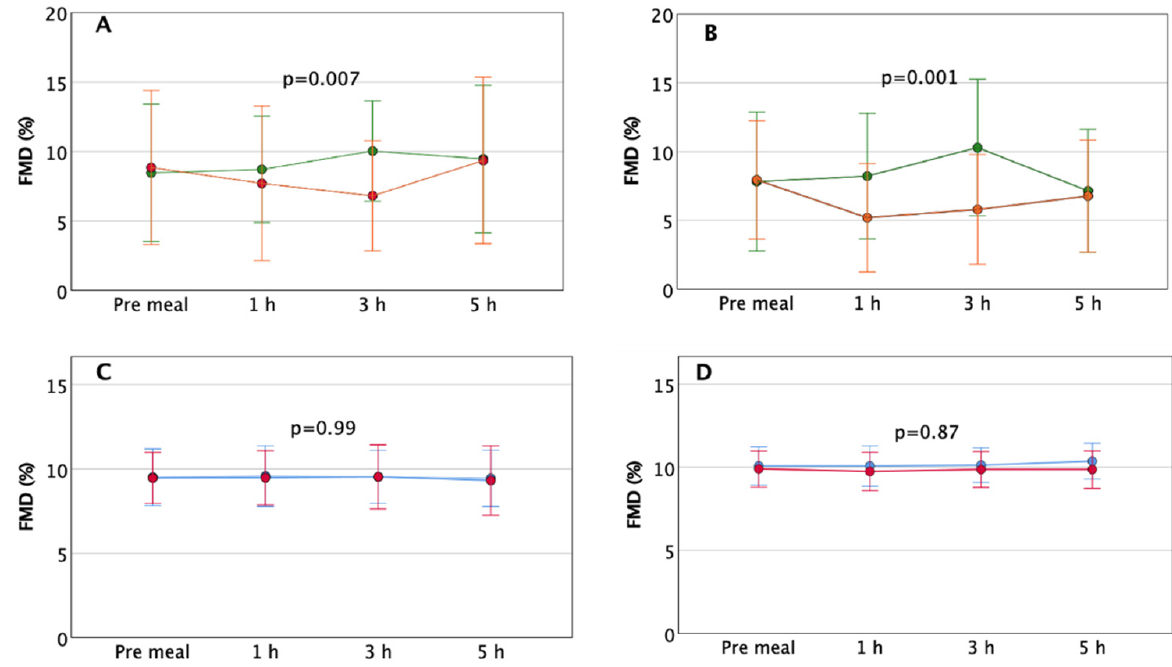
Figure 1. Flow-mediated dilation (FMD) before and after EVOO- and butter-enriched test meals in T1D and control subjects. ( A ) FMD after ischemia in T1D (green EVOO, orange butter); ( B ) FMD after handgrip exercise in T1D (green EVOO, orange butter); ( C ) FMD after ischemia in control subjects (blue EVOO, red butter); ( D ) FMD after handgrip exercise in control subjects (blue EVOO, red butter).